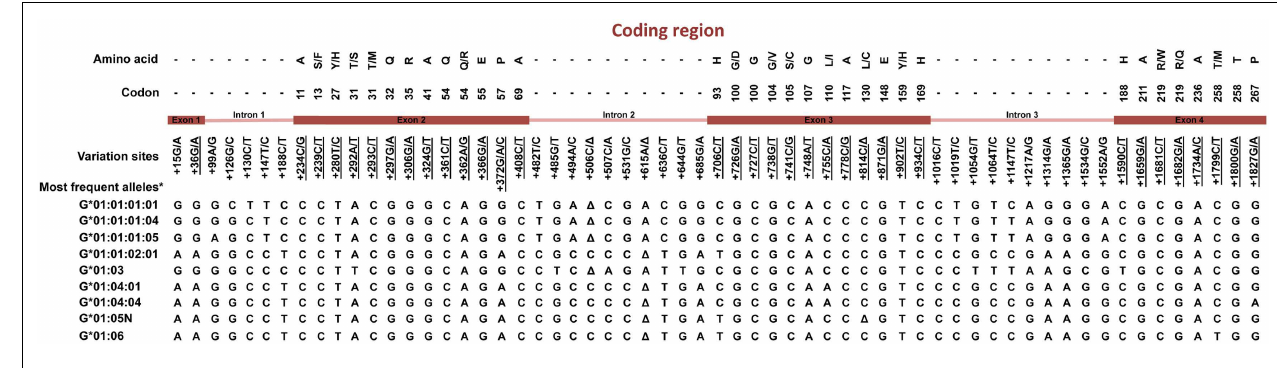
serine; F, phenylalanine;Y, tyrosine;T, threonine; M, methionine; Q, glutamine; R, arginine; E, glutamic acid; P, proline; H, histidine; G, glycine; D, aspartic acid;V, valine; C, cysteine; L, leucine; I, isoleucine; W, tryptophan. ∆ ,